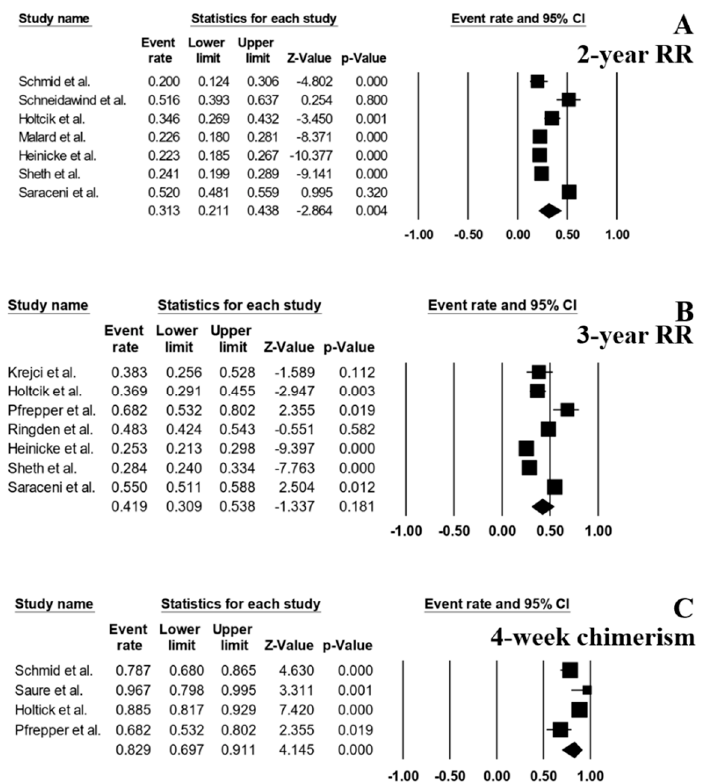
Figure 3. Forest plots of pooled estimates ( 95 % CI ) for relapse rate (RR) and outcome after HSCT; ( A ) : 2 - year RR; ( B ) : 3 - year RR; ( C ) : full chimerism at 4 weeks after